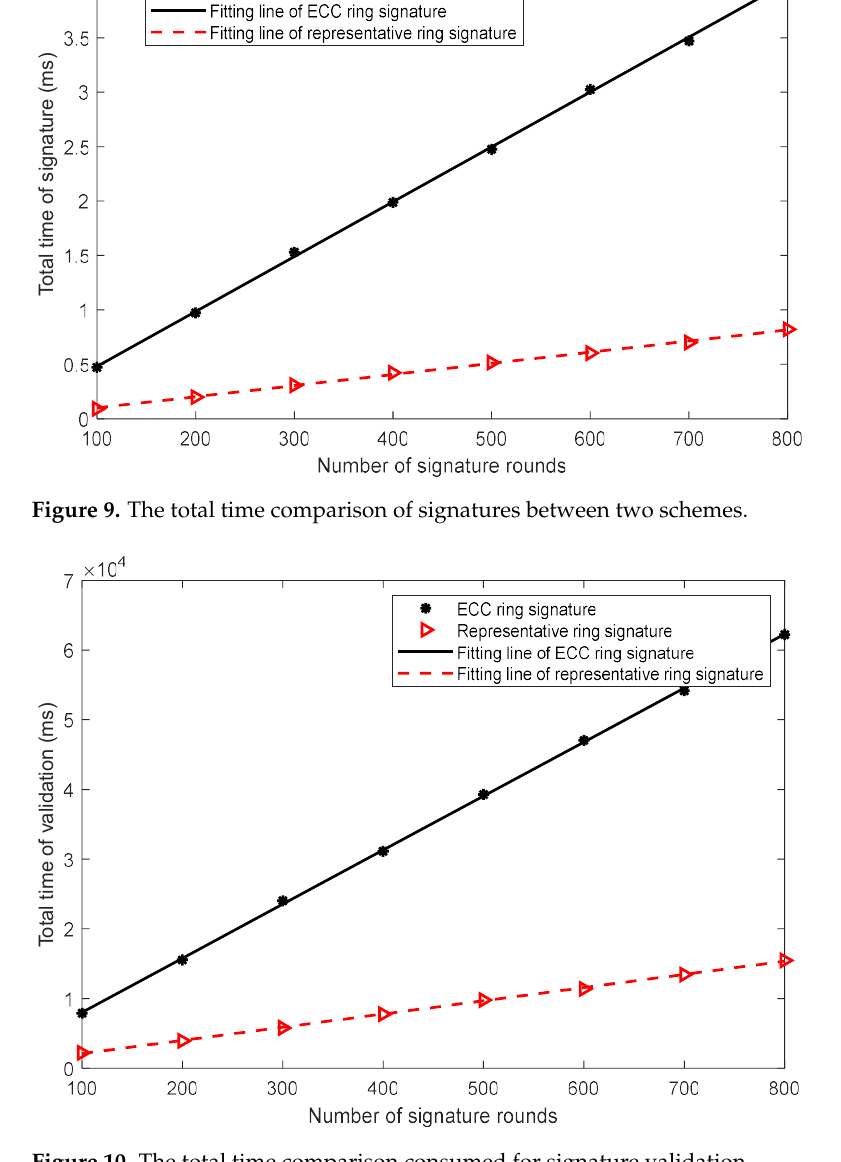
Figure 9. The total time comparison of signatures between two schemes.